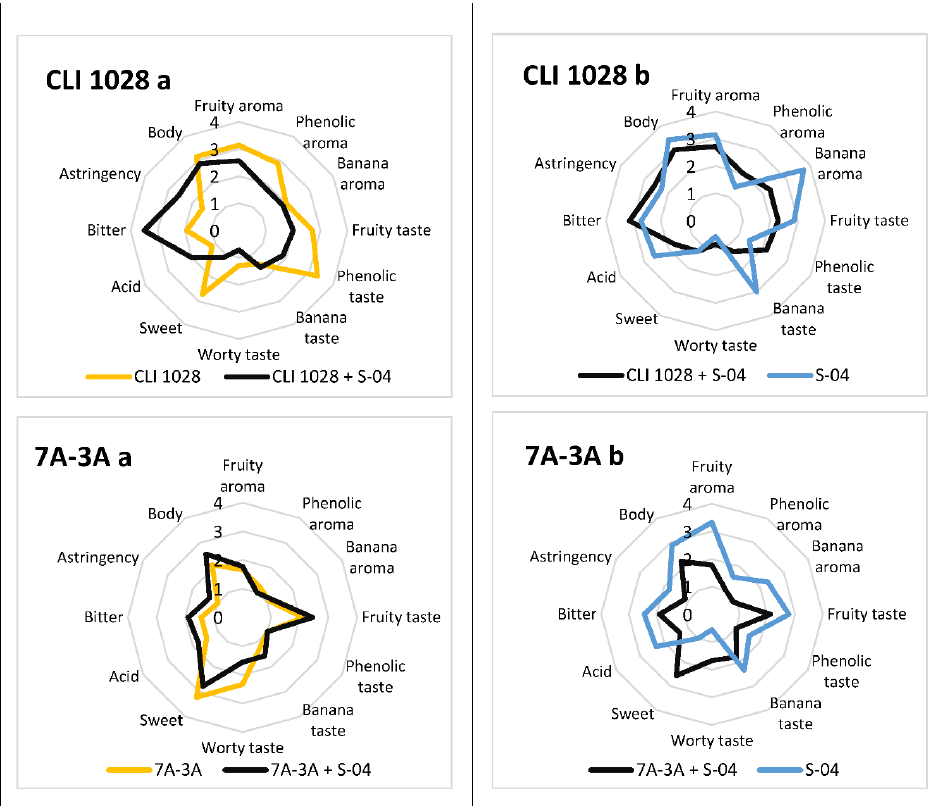
Figure 4. Sensory analyses of the different beers fermented in pure culture and sequential culture using a pared comparison test. ( A ) Sensory analyses of non- Saccharomyces pure cultures compared to sequential cultures. ( B ) Sensory analyses of sequential cultures compared to S-04 single culture;